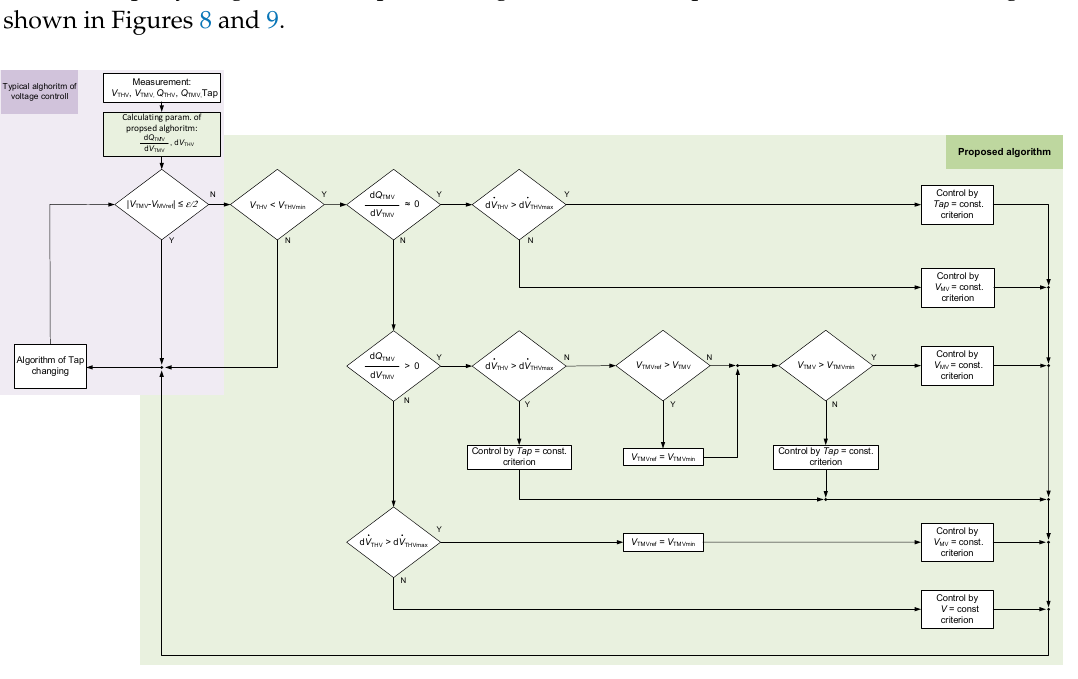
Figure 8. Block diagram of the proposed algorithm of the HV/MV substation transformer controller.